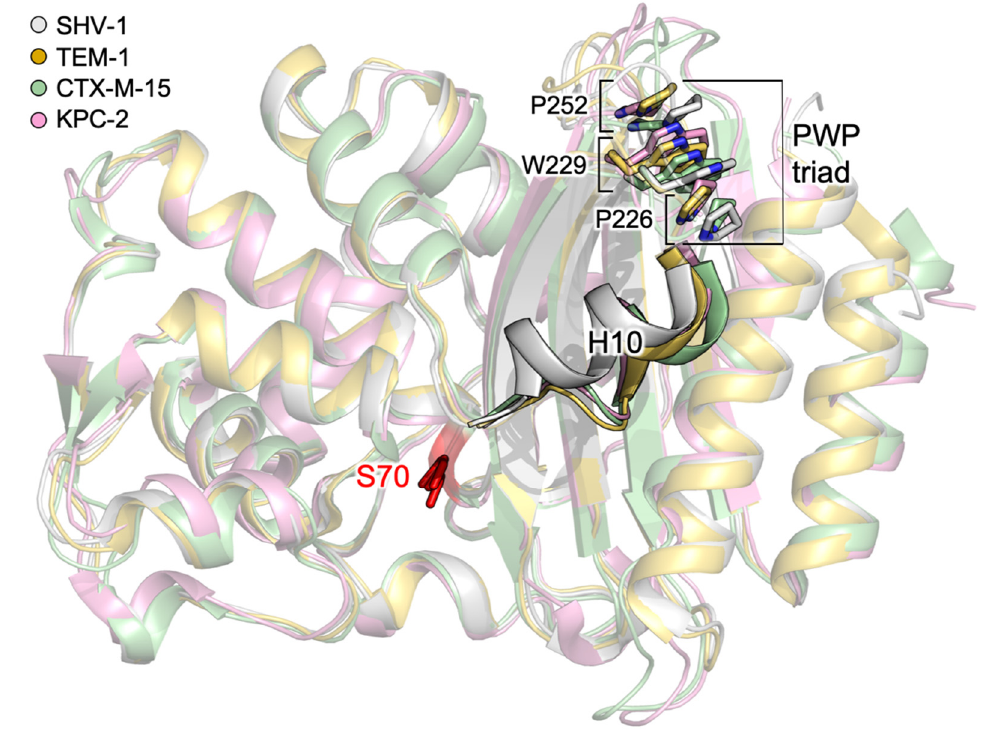
Figure 6. PWP triad in class A BLs. Pro226, Trp229, Pro252 and the catalytic serine are shown in capped sticks. Helix 10 is displayed in cartoon. SHV-1 (gray), TEM-1 (dark yellow), CTX-M-15 (green), KPC-2 (pink) (PDB IDs: 4zam, 1ero, 4hbt, 3rxw, respectively).